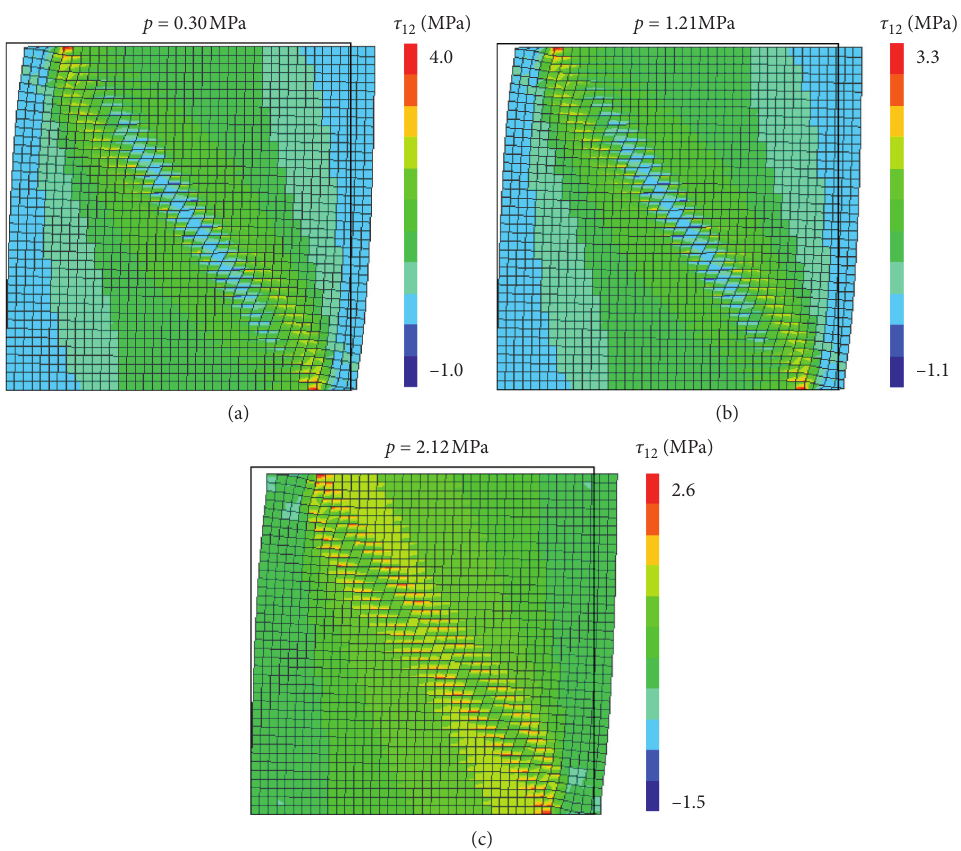
Figure 7: Deformed configuration and shear stresses at d � 2 mm of the pushover tests performed with the